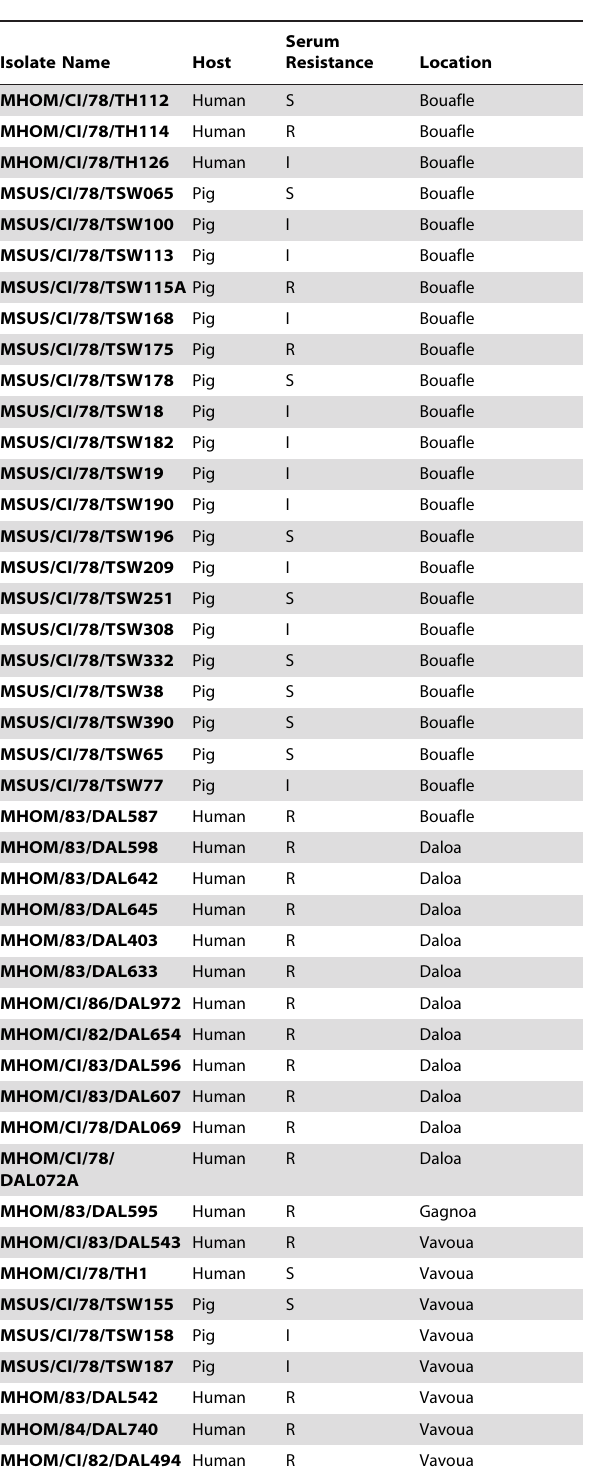
Table 1. Details of the isolates used in the study, including the isolate name, the host each strain was isolated from, the serum resistance profile resulting from a 5 rodent BIIT (R=highly resistant, I=intermediate or sub-resistant and S =sensitive) and the geographic location of the isolate when collected within Coˆte d’Ivoire.